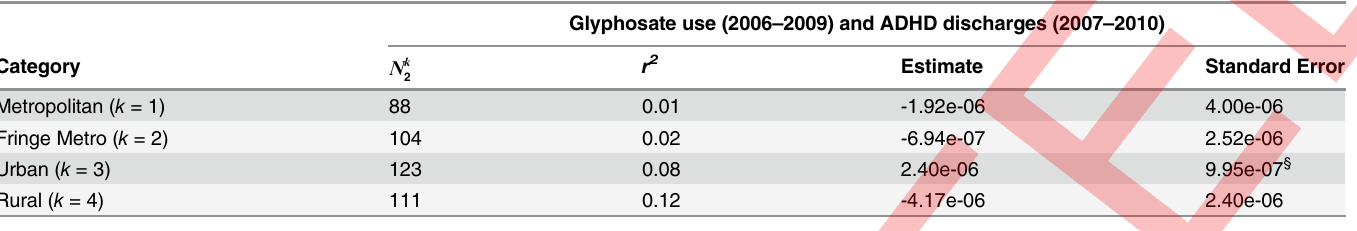
Table 4. The effect of urbanization on the relationships between glyphosate use and ADHD hospital discharges, using two ways fixed effects within model in R and adjusting for heteroskedasticity and serial correlation and including all significant covariates that passed screening in Model